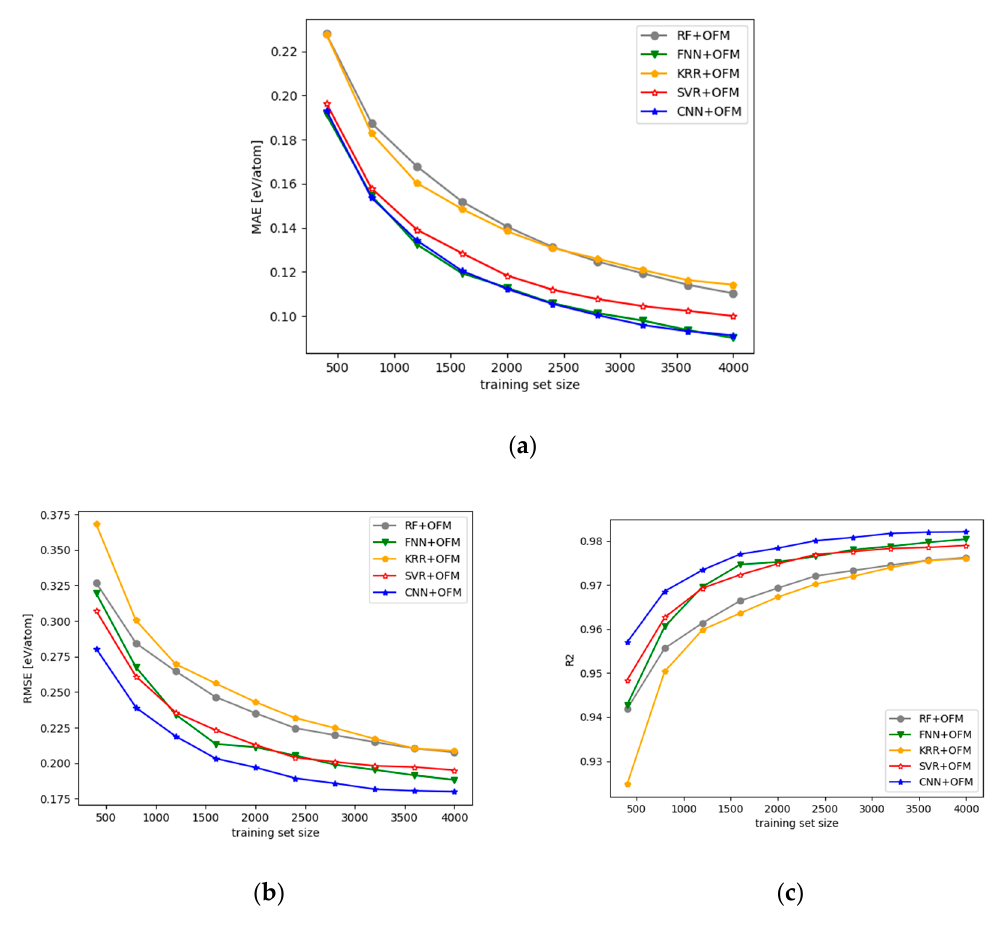
Figure 3. Prediction performances of different models using OFM features. ( a ) MAE of different training set size. ( b ) RMSE of different training set size. ( c ) R 2 of different training set size. Table 1. RMSE ( eV/atom), MAE (eV/atom) and R 2 values of cross-validation results of all prediction models using the OFM descriptor.